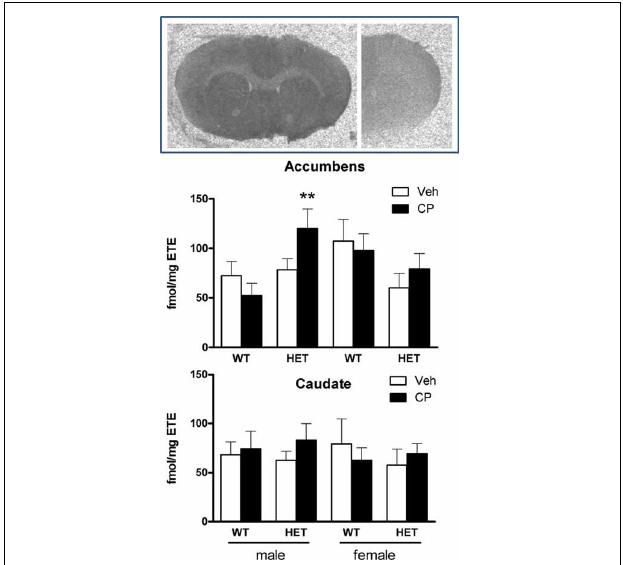
FIGURE 8 | Top: typical autoradiograms of [ 3 H]CP55,940 binding in the mouse forebrain, showing total binding (left) and non-specific binding (right). Specific binding densities were expressed as fmol/mg estimated tissue equivalent (ETE) in the nucleus accumbens ( Middle ) and caudate nucleus ( Bottom ) of male and female WT/veh, WT/CP, HET/veh, and HET/CP. Data are mean ± SEM. ∗∗ P < 0 . 05 for difference with BDNF HET mice which had received chronic vehicle